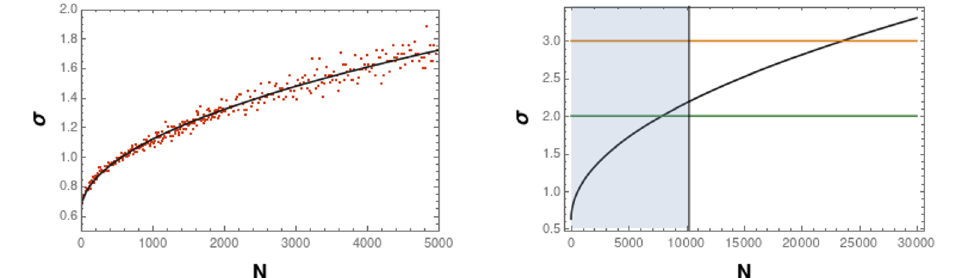
Figure 4 . Number of Higgs to four lepton events N required to distinguish the SM from a large Zγ model benchmark at a given significance σ . The left figure shows the curve fitted to the average statistical significance of pseudo-experiments featuring a given number of events (the red points). The right figure shows an extrapolation of this data with lines at 2 and 3 σ significance. The blue shaded region shows the expected reach of the HL